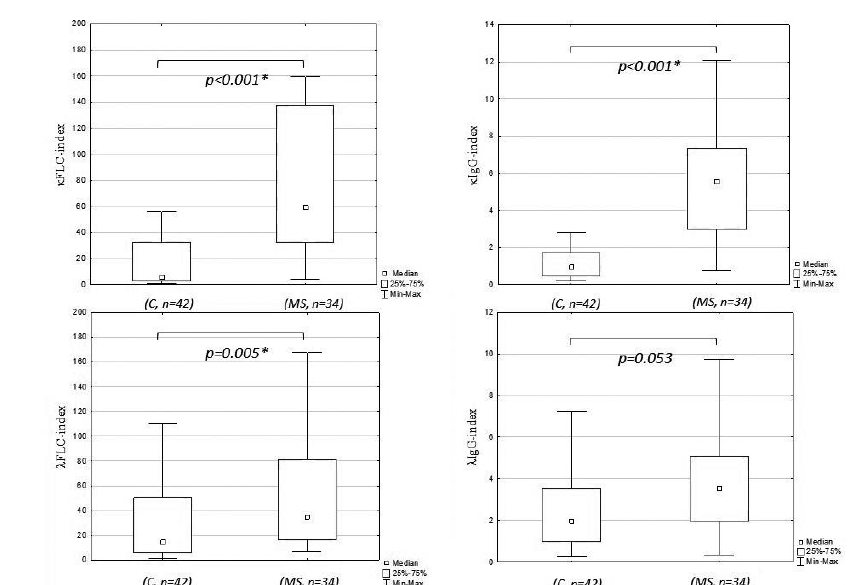
Figure 2. κ FLC index, λ FLC index, κ IgG index, and λ IgG index in the study groups. C, control group; Figure 2. κFLC index, λFLC index, κIgG index, and λIgG index in the study groups. C, control group; MS, multiple sclerosis; *, significant di ff erences in comparison to the MS, multiple sclerosis; *, significant differences in comparison to the controls.